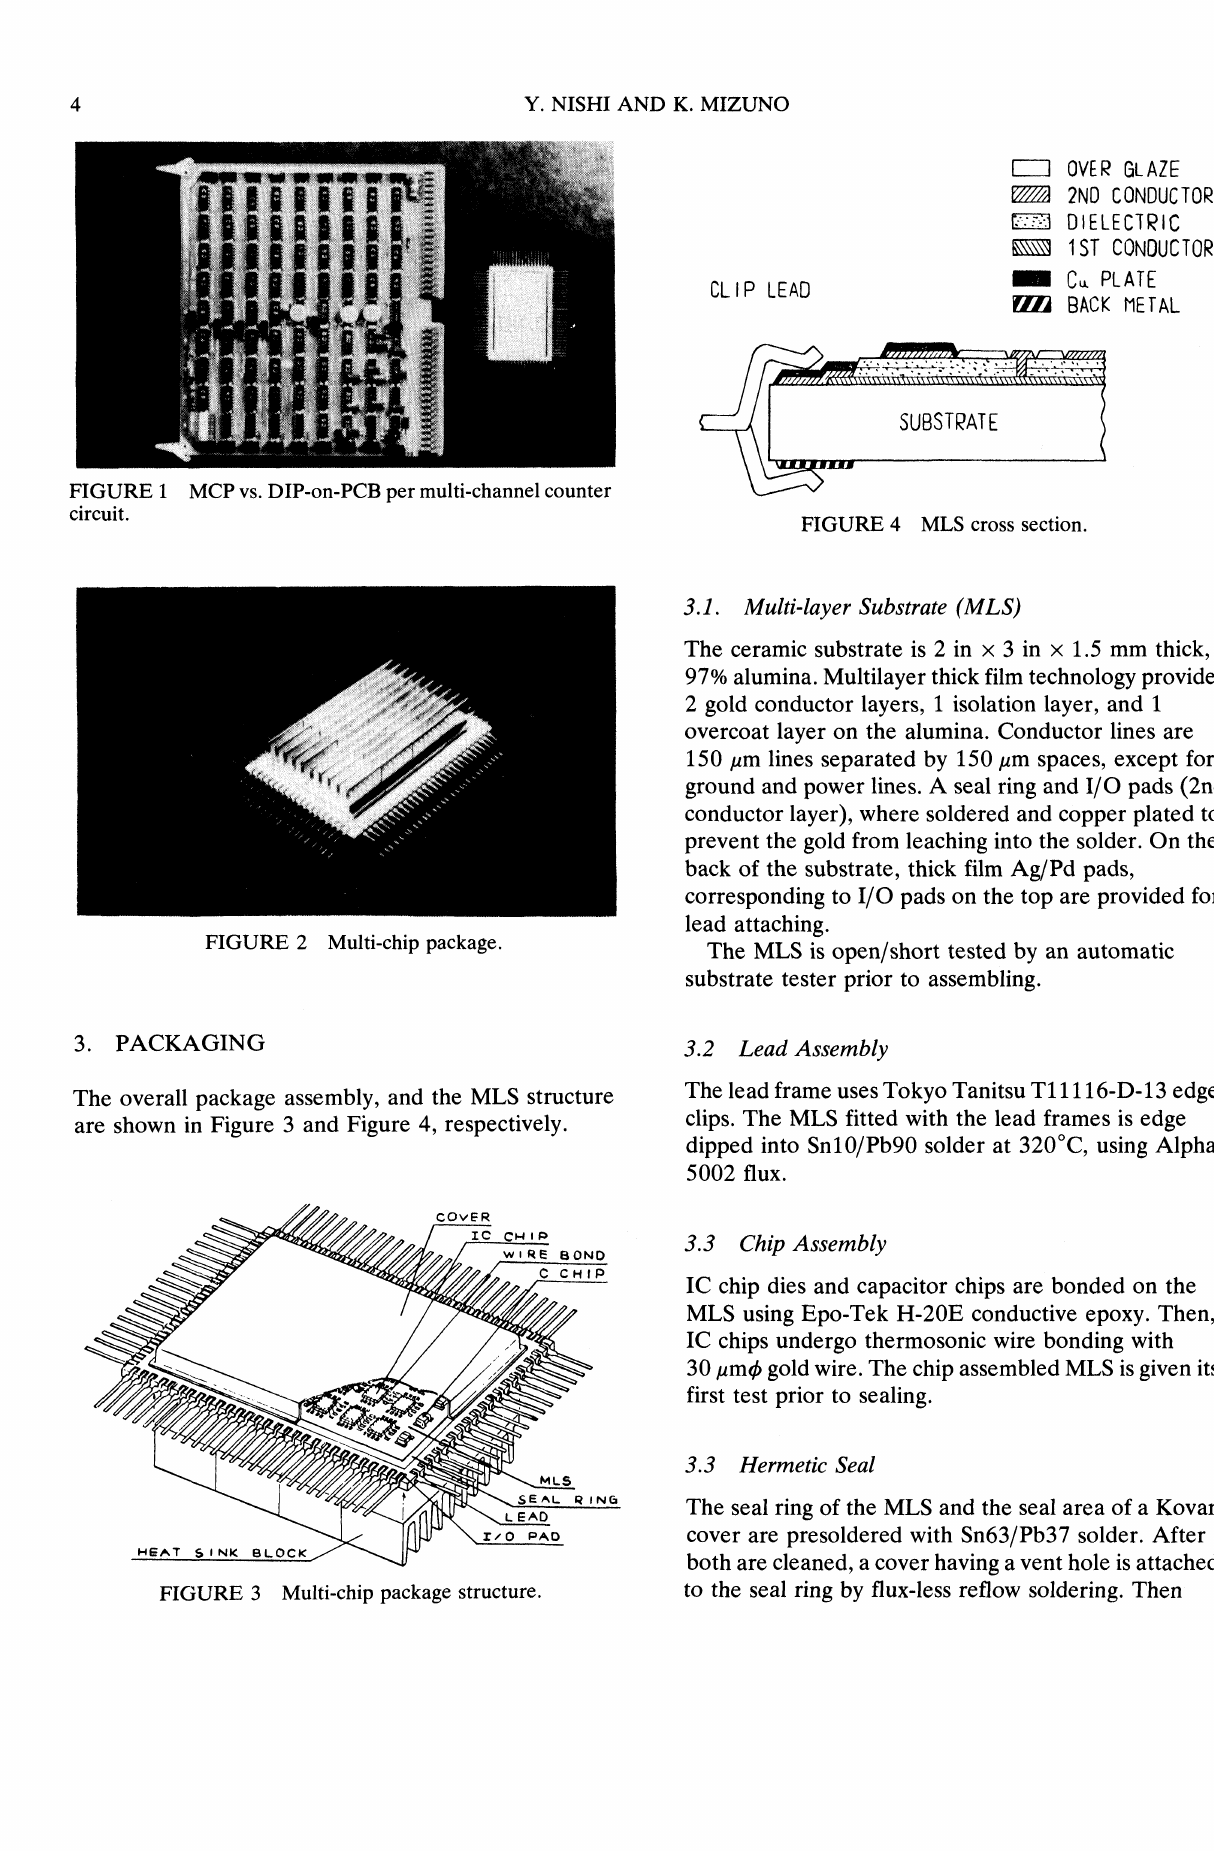
4 MLS cross section.